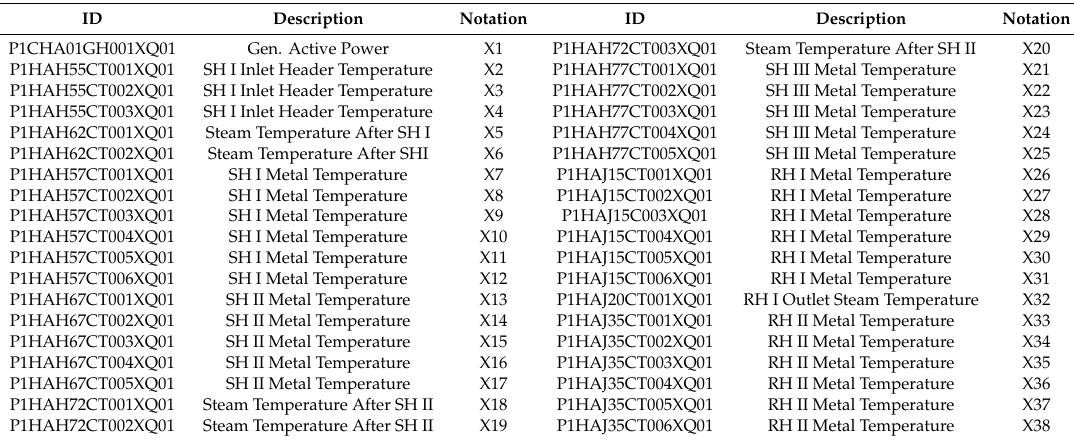
Table 1. Most sensitive sensor data from the Steam power plant used for boiler waterwall tube leakage